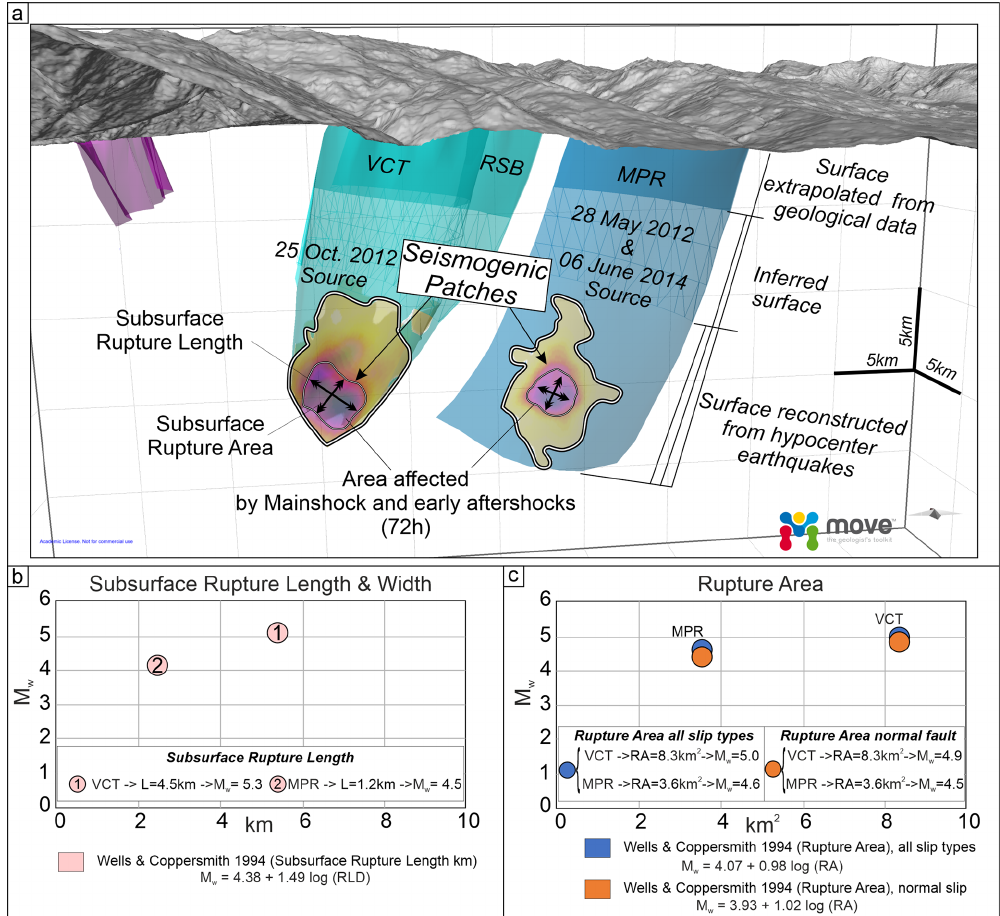
Figure 10. (a) Seismogenic patches activated during the 2010–2014 seismic activity on VCT and MPR faults. Their along-strike elongation and area extent, shown by black arrows, are assumed to be the effective subsurface rupture length and rupture area (RLD and RA, according to Wells and Coppersmith, 1994). The association of the patches’ rupture with the M w 5 . 2 Mormanno of the 25 October 2012 (on VCT fault) and M w 4 . 3 and 4.0 Morano Calabro (on MPR fault, 28 May 2012 and 6 June 2014, respectively) earthquakes is suggested. Panels (b) and (c) show the RLD and RA, respectively, obtained for both the VCT and MPR